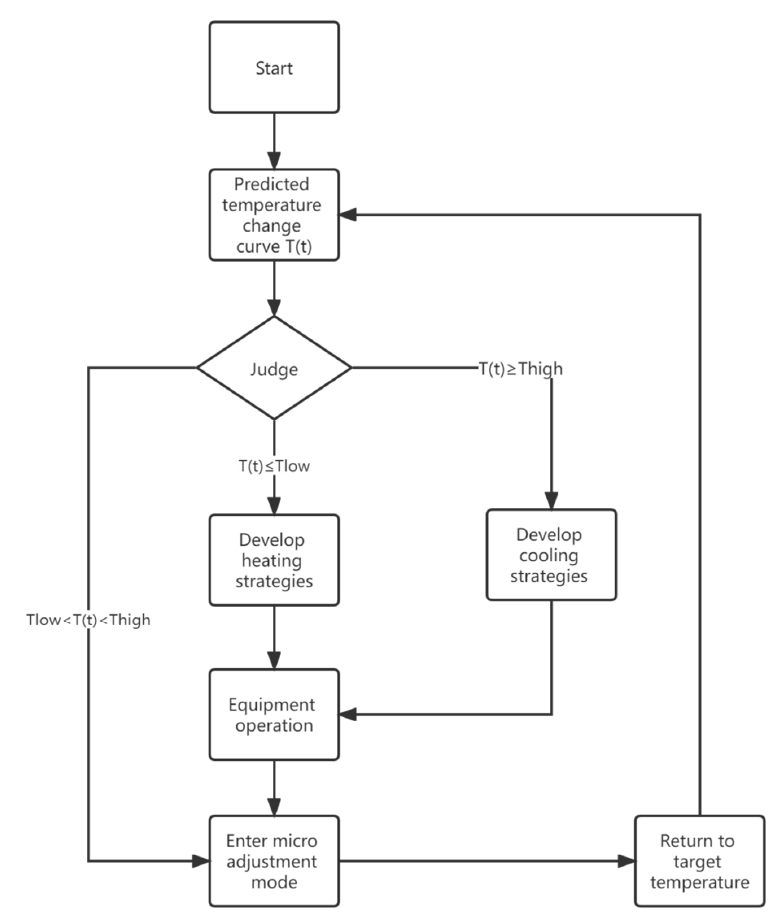
Figure 5. Flow chart of macroscopic regulation of indoor temperature.